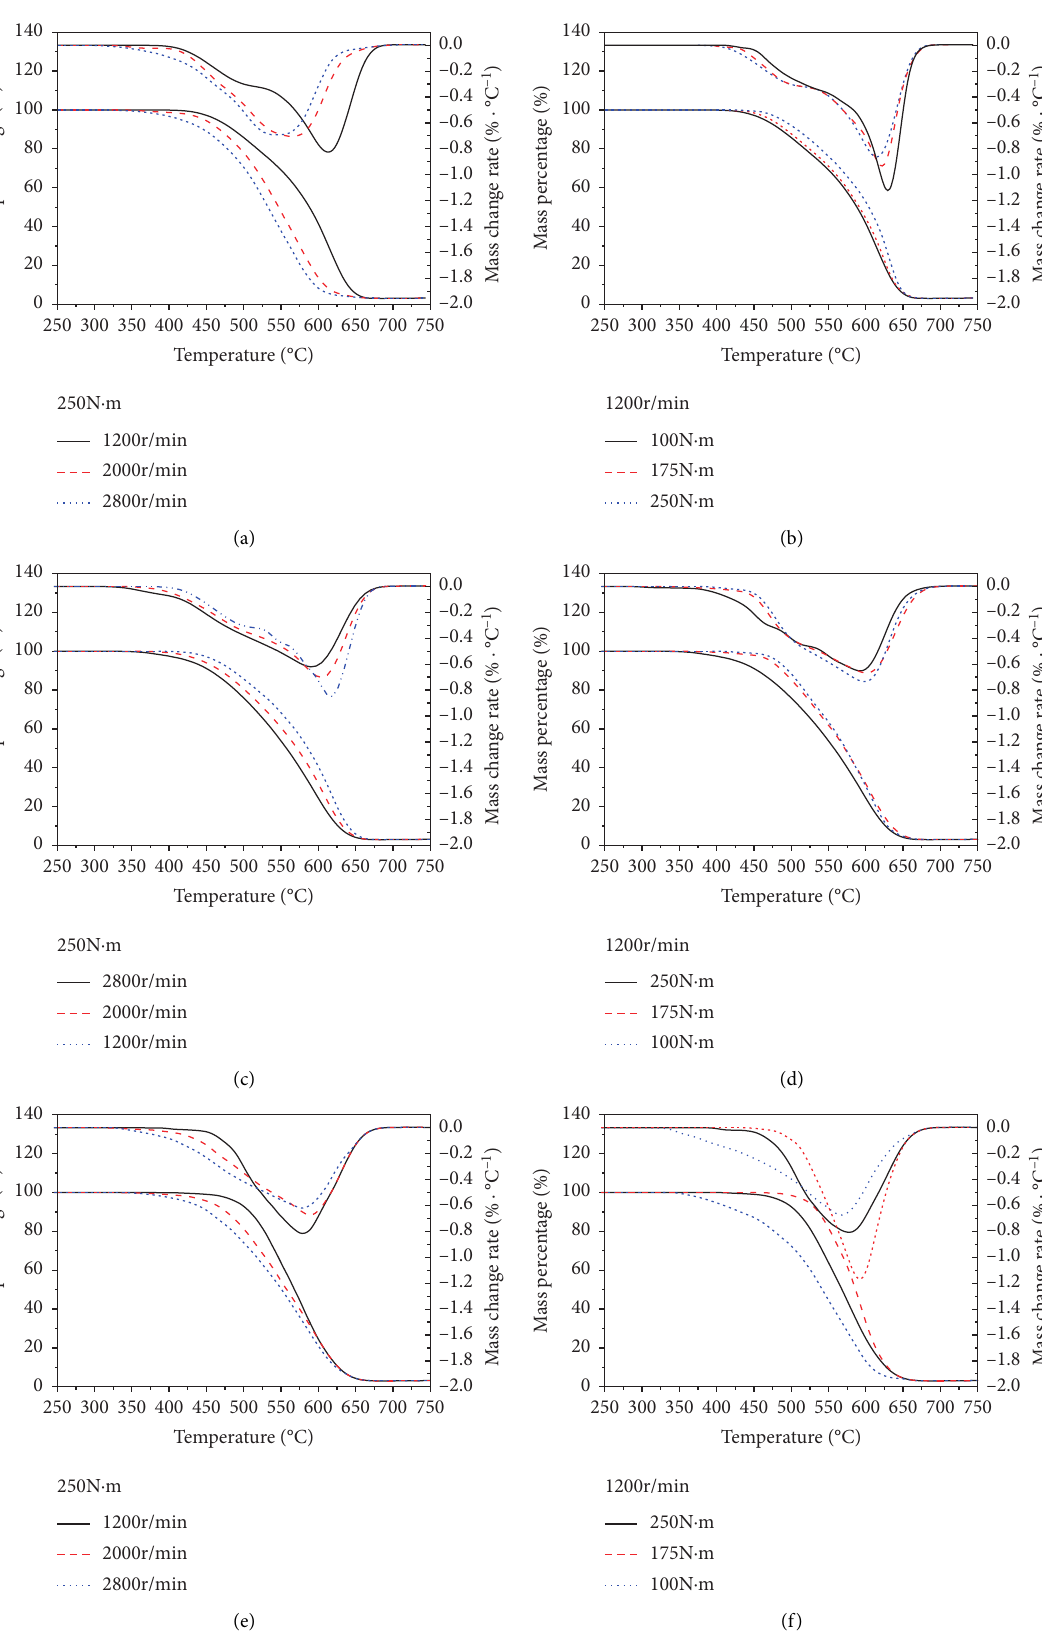
Figure 3: The thermogravimetric analysis results of particulate matter samples from diesel engine bench tests using three different fuels. (a) Fuel A: rotational speed. (b) Fuel A: torque. (c) Fuel B: rotational speed. (d) Fuel B: torque. (e) Fuel C: rotational speed. (f) Fuel C: